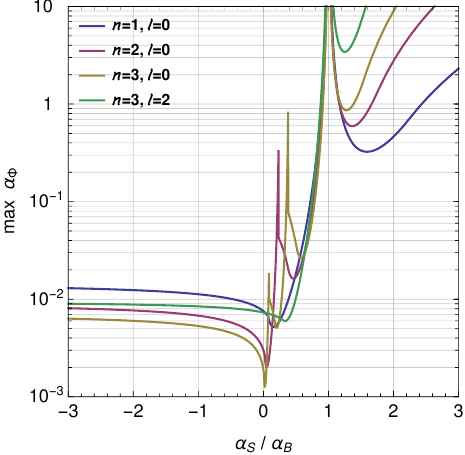
Figure 8 . The maximum value of (cid:11) remain below the unitarity limit for all